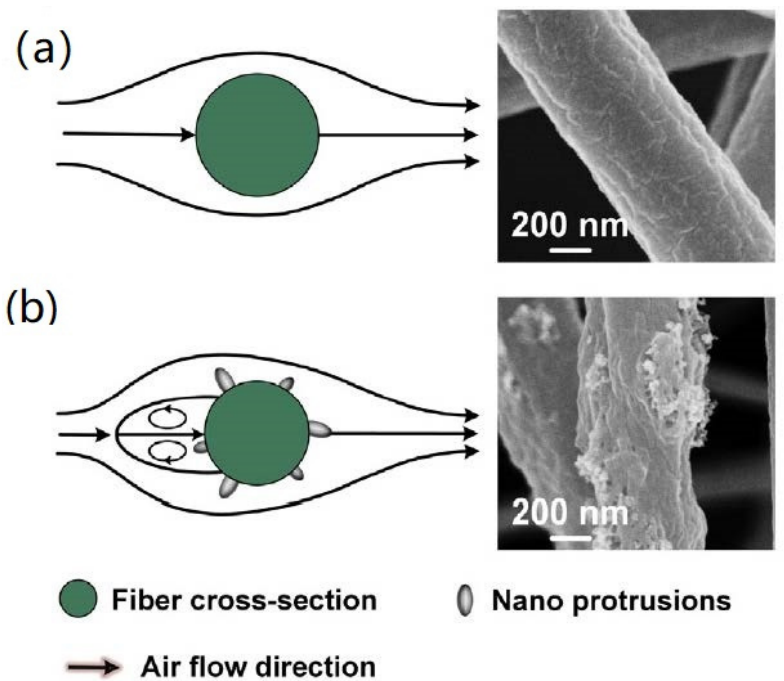
Figure 7. Streamlines are forming around circular ( a ) and non-circular ( b ) cross-sections of a fiber. (left). SEM image of the fibers (right). (Reprinted with permission from [50]. Copyright 2014 Else- vier.).